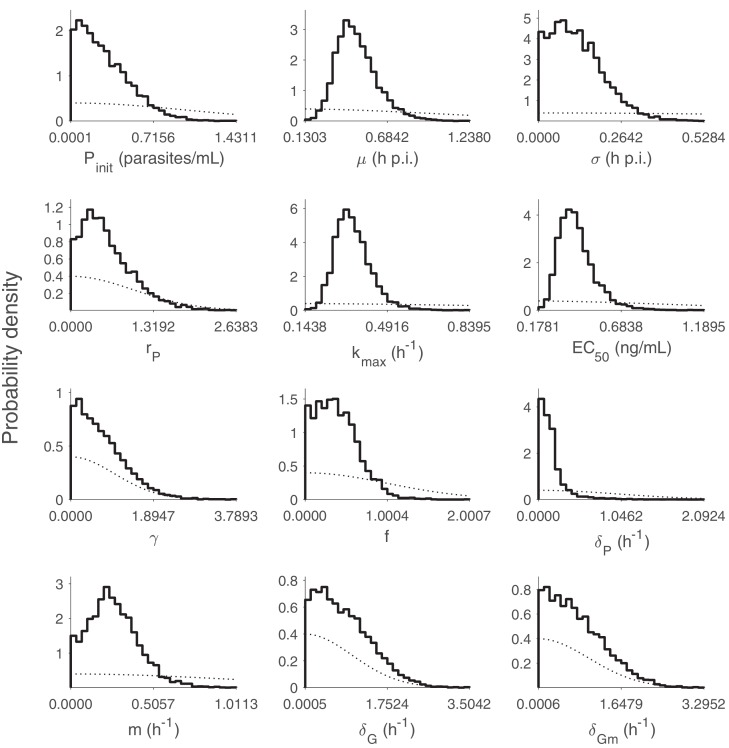
Marginal posterior distributions for the 12 population SD parameters (hyperparameters).5000 samples are used to generate the distributions. The dashed curves indicate the half-normal prior distributions. p.i.: post-inoculation. Note that the y-axis is probability density instead of number of samples. Relevant details of the hyperparameters are provided in the Materials and methods in the main text.